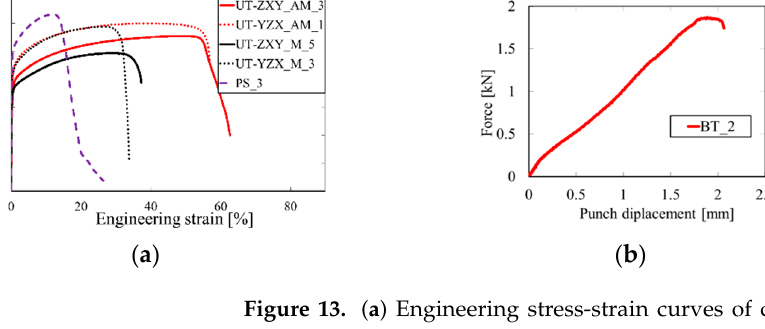
Table 3. Results of tensile, plane strain, biaxial and compression testing including the dimensions